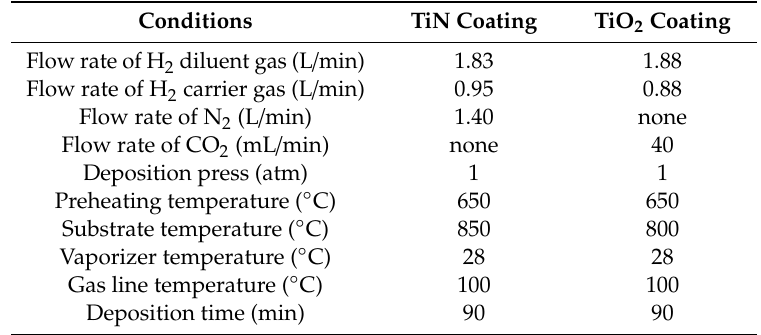
Table 1. A typical experimental condition for the preparation of the TiN and TiO 2